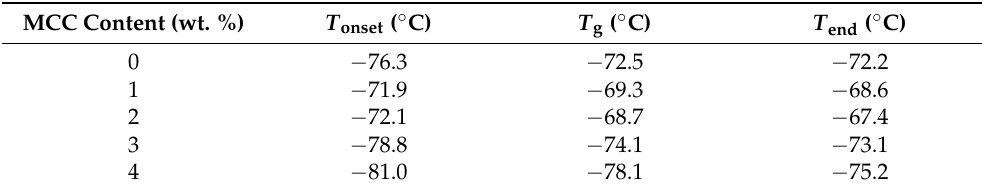
Table 2. The effect of cellulose content on phase-transition temperatures for BMImAc/MCC